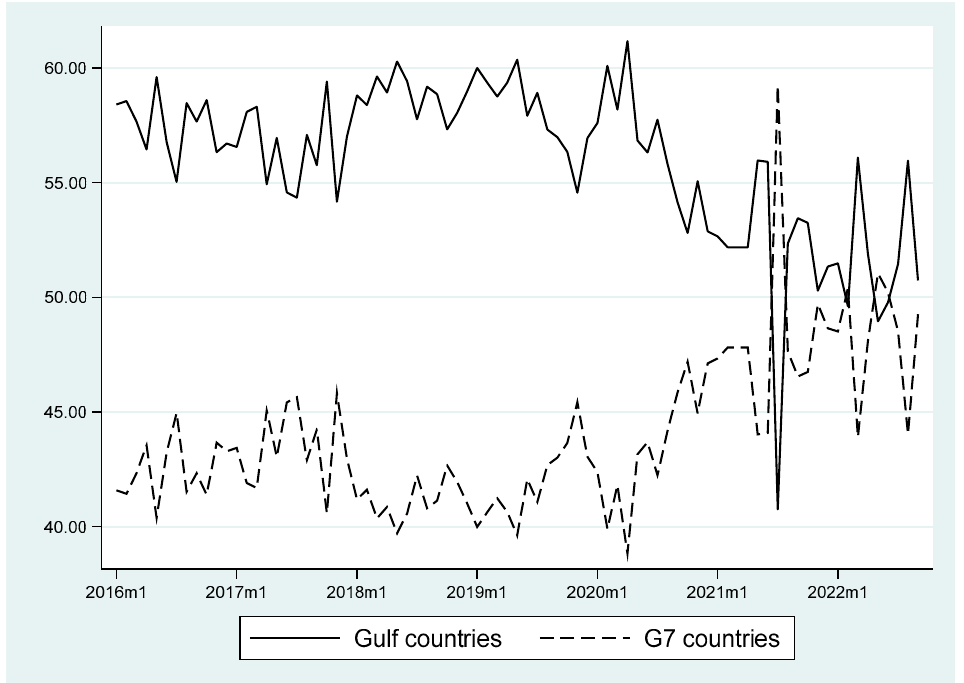
Figure 1. Trends of the remi tt ance in fl ows to Bangladesh. Source: Bangladesh Bank. Note: The vertical axis shows the percentage share of the remi tt ance to the total remi tt ance amount.